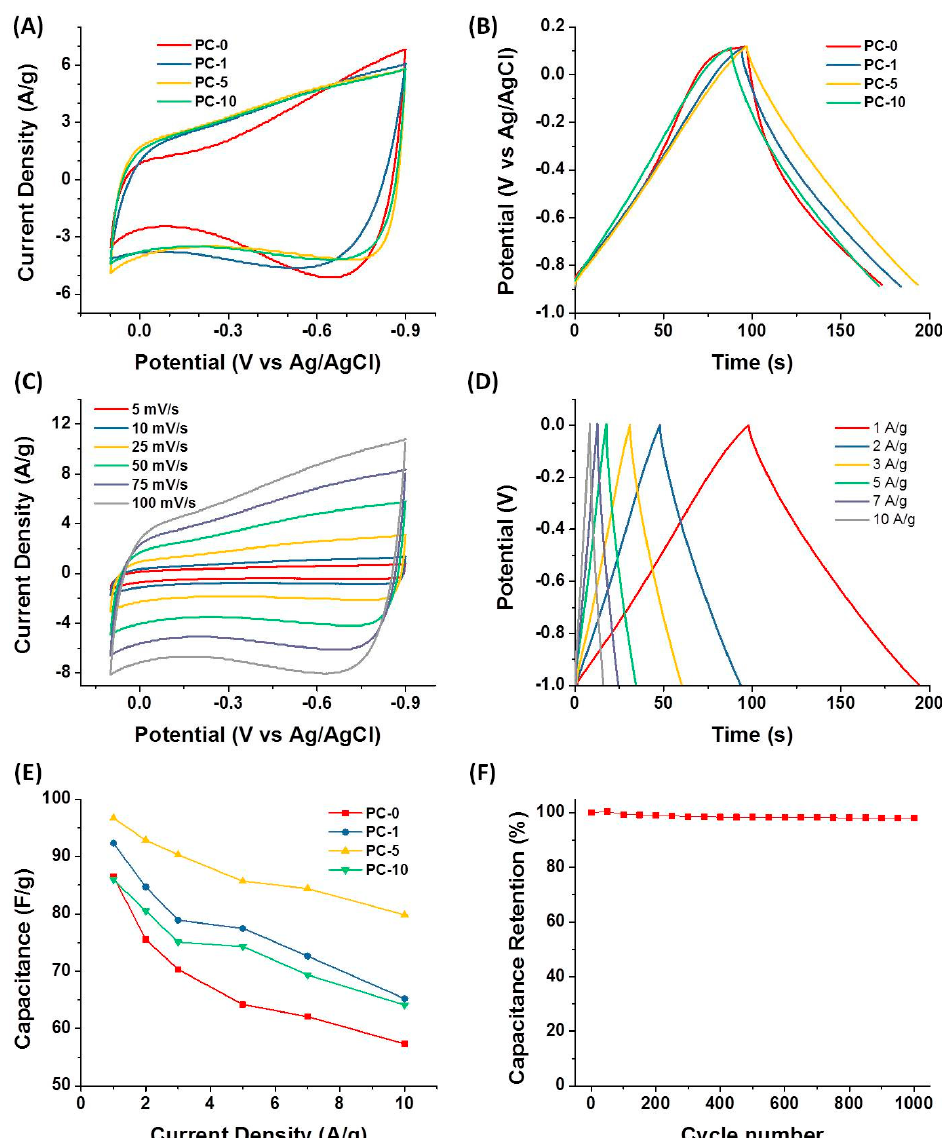
Figure 6. ( A ) The cyclic voltammogram (CV) curves of all porous carbon materials at the scan rate of 50 mV/s measured in a three-electrode system; ( B ) Galvanostatic charge/discharge (GCD) curves of all porous carbon materials at 1 A/g measured in a three-electrode system; ( C ) CV curves of PC-5 electrode material at different scan rates measured in a three-electrode system; ( D ) GCD curves of the PC-5 electrode at different current densities measured in a three-electrode system; ( E ) specific capacitances of all porous carbon electrode materials at different current densities in a three-electrode system; ( F ) Cycling stability measured for PC-5 at 1 A/g measured in a three-electrode system.